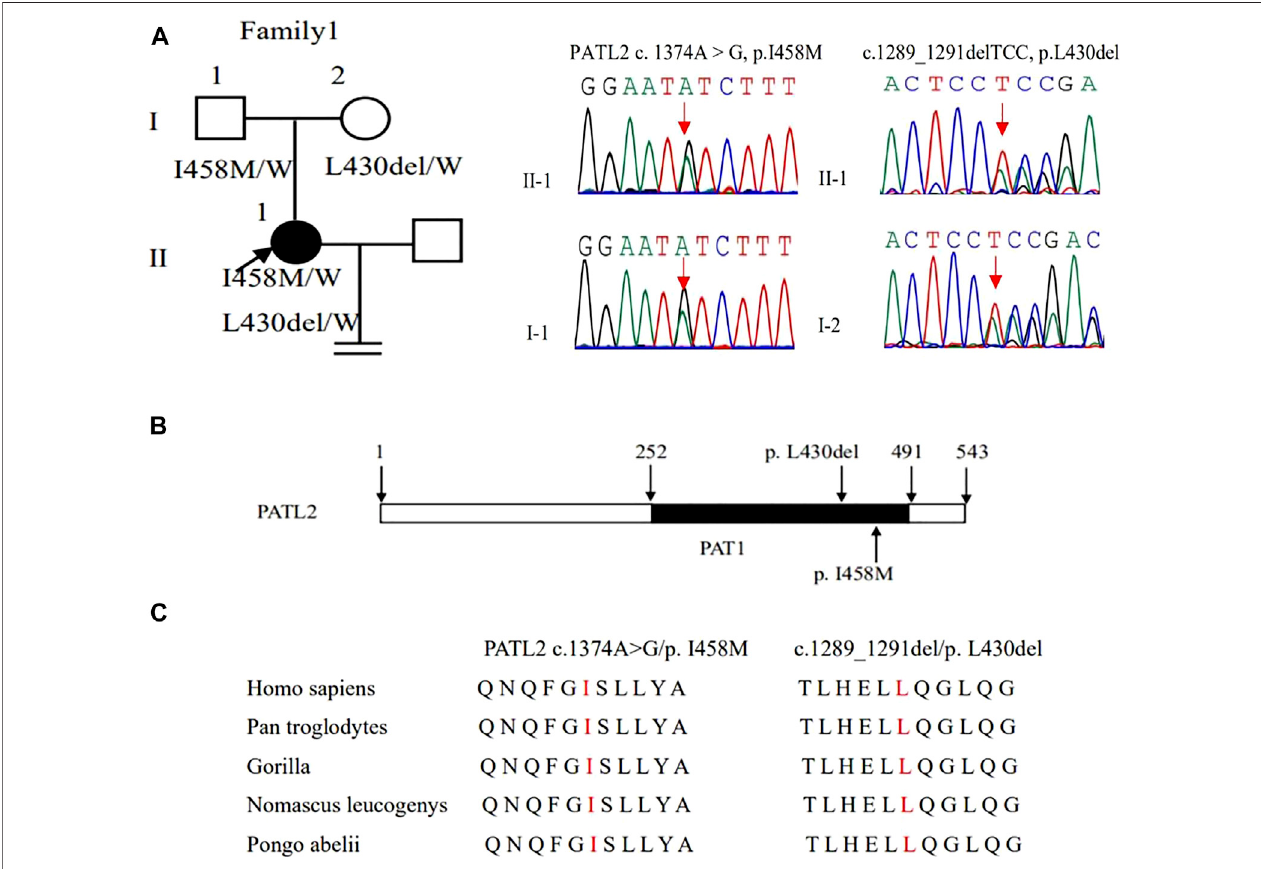
FIGURE 2 | Genotypic features of family 1. (A) Pedigrees of family 1 with female infertility. Sanger sequencing con fi rmation is shown on the right of the pedigrees. The “ = ” sign indicates infertility, and black circles represent affected individuals. The “ W ” sign means wild type. (B) The positions of the novel mutations are indicated in the corresponding amino acids shown on the PATL2 protein. (C) Preservative mutation analysis for the novel sites in different species.